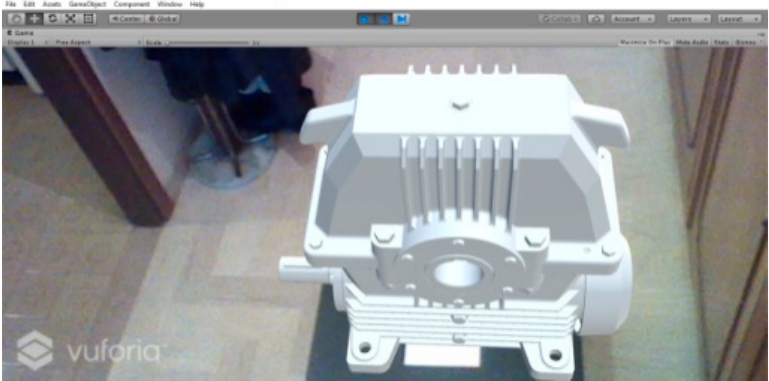
Figure 30. View of the gearbox in AR (scale 1:1).